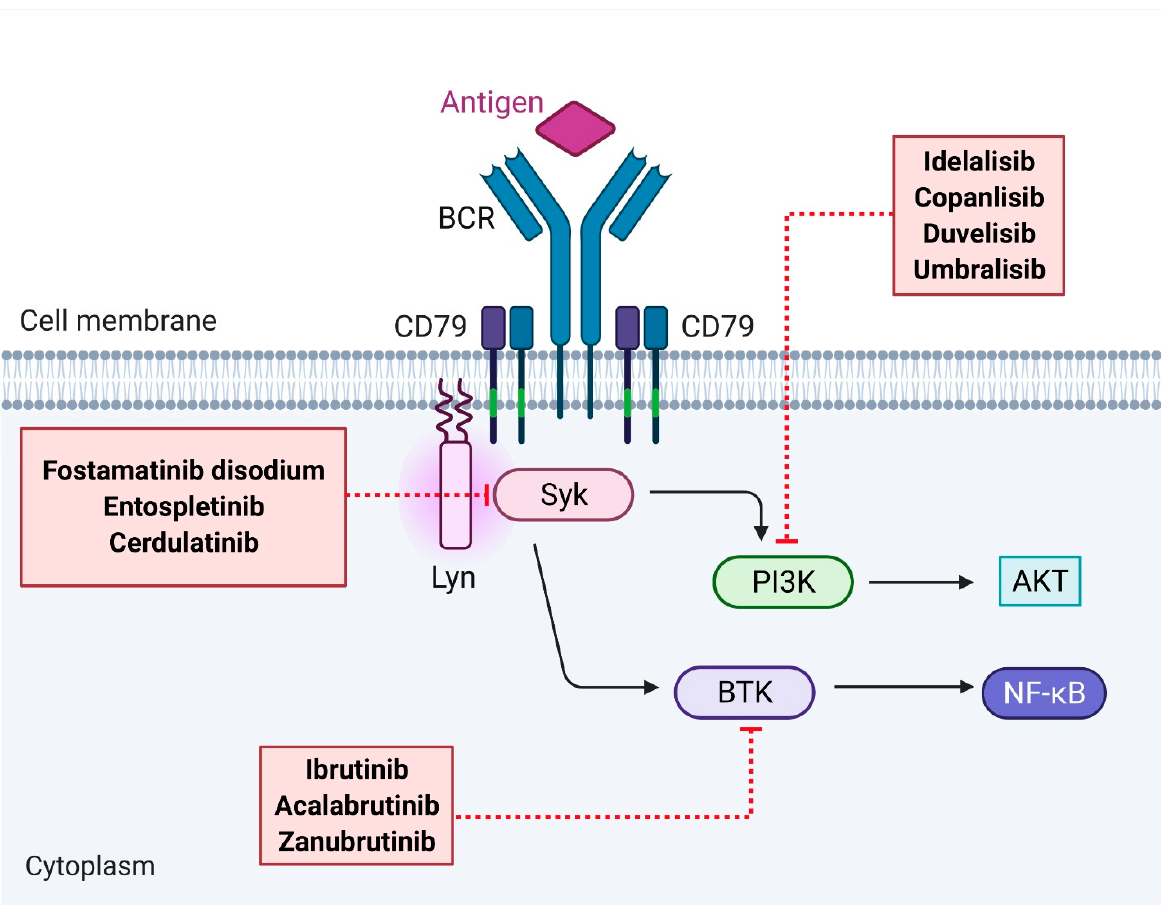
Figure 2. Therapeutic agents targeting the B-cell receptor (BCR) signaling pathway in follicular lymphoma. Abbreviations: BCR, B-cell receptor; Lyn, tyrosine-protein kinase Lyn; SYK, spleen tyrosine kinase; BTK, Bruton tyrosine kinase; PI3K, phosphatidylinositol-3-kinase.